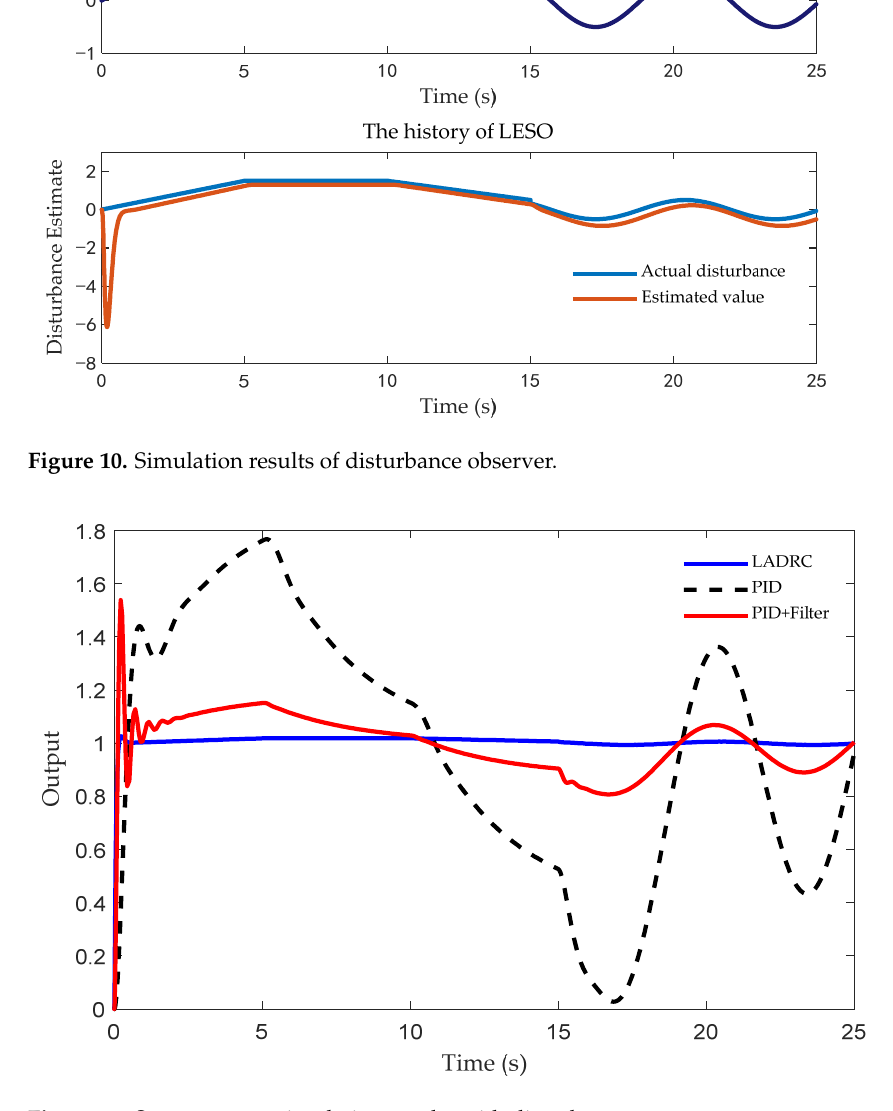
Figure 11. Step response simulation results with disturbance.